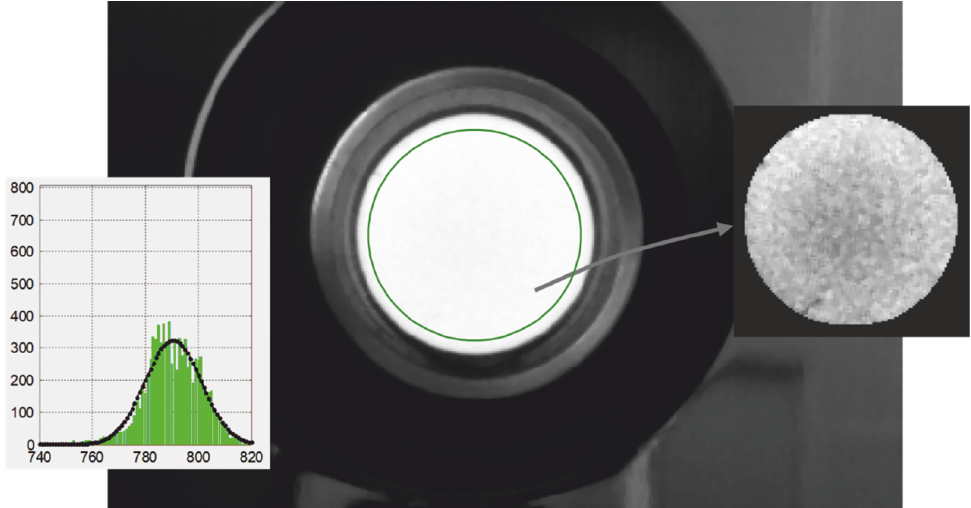
Figure 15. The image of the output diaphragm of the M390 black body model recorded by the thermograph in the second spectral region at a temperature of its radiating core of 800 °C and an exposure time of 130 ms, as well as an image of its central zone with a range of D 2 signals from 760 to 820 ADC counts and the corresponding histogram approximated using normal distribution.